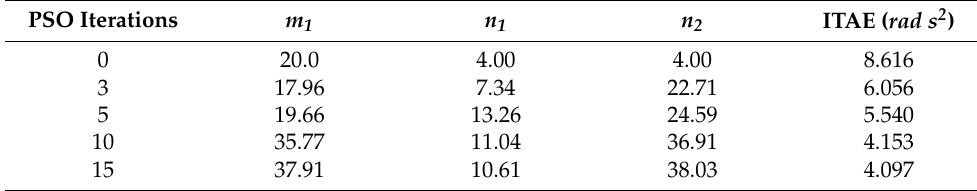
Table 1. PSO controller performance in term of ITAE.